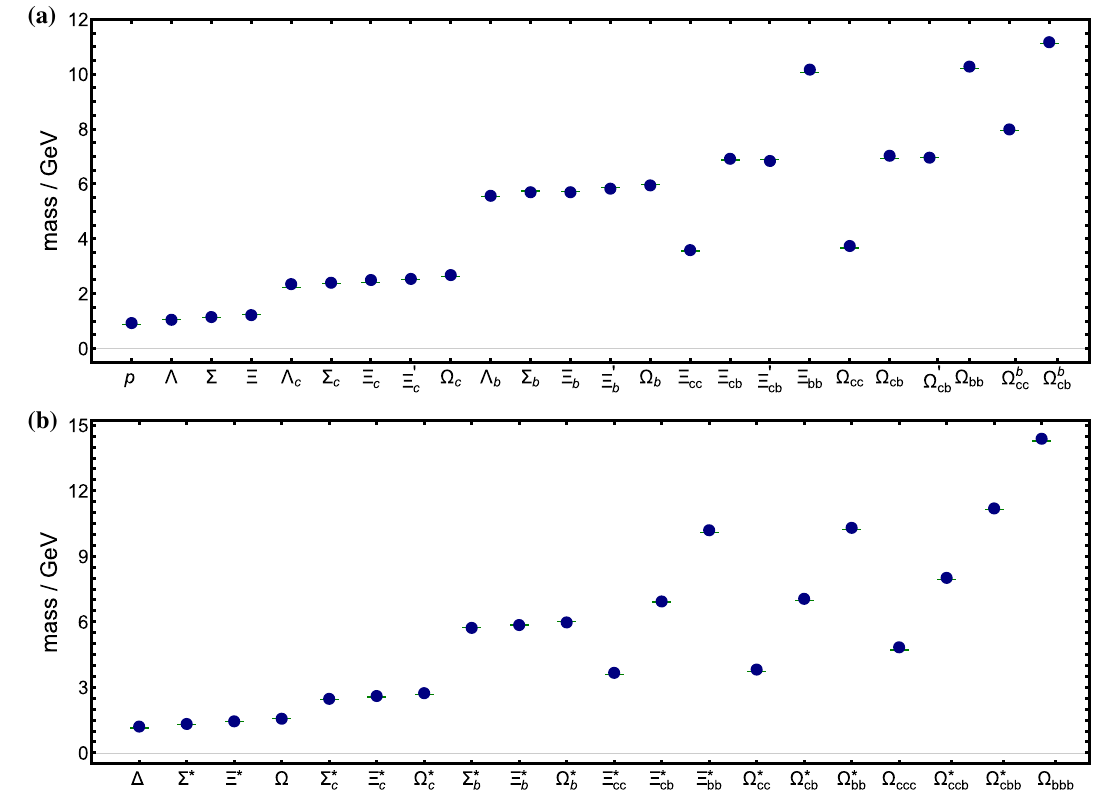
Fig. 4 Upper panel – a CI computed masses (in GeV) of ground-state flavour-SU ( 5 ) J P = 1 / 2 + baryons in Table 3 compared with either experiment (first 15) [1] or lQCD (last 9) [18,21]. Lower panel – b Sim-